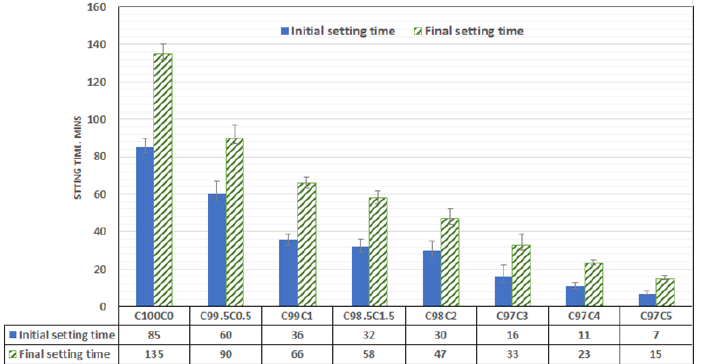
Figure 6. Setting time of coffee-silver-skin-blended mortar.